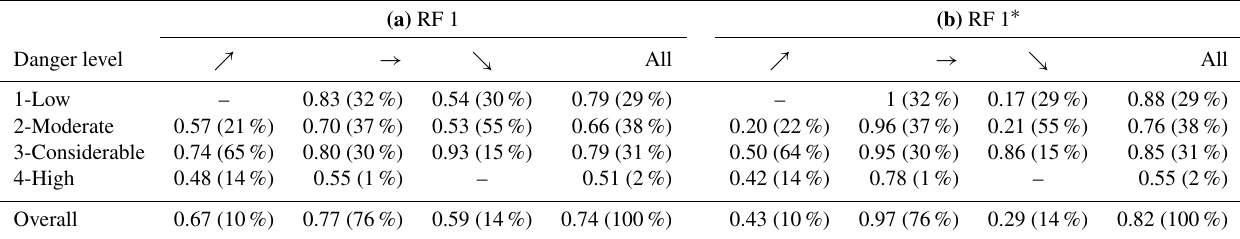
Table 3. Accuracy of RF predictions (proportion of samples – row-wise sum for “Overall” and column-wise sum for the rest) of a RF classifier tested against D forecast as a function of changes in the forecast danger level compared to the day before, for cases when the danger level increased ( (cid:37) ), stayed the same ( → ), or decreased ( (cid:38) ) for (a) RF 1 and (b) RF 1 ∗ , a model which additionally considers the forecast danger level of the previous day as an input